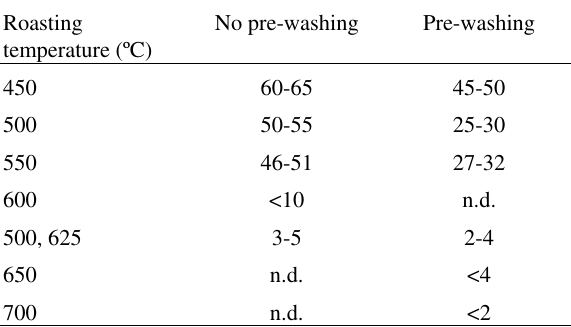
Table 4. Lime consumption with roasted products,